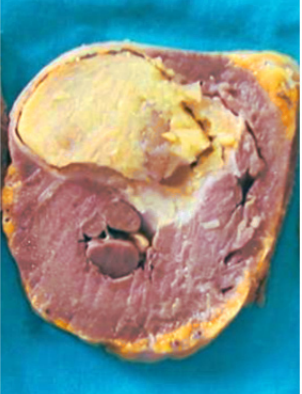
Figure 2. Right ventricle intra-cavitary cyst (after fixation in formalin).